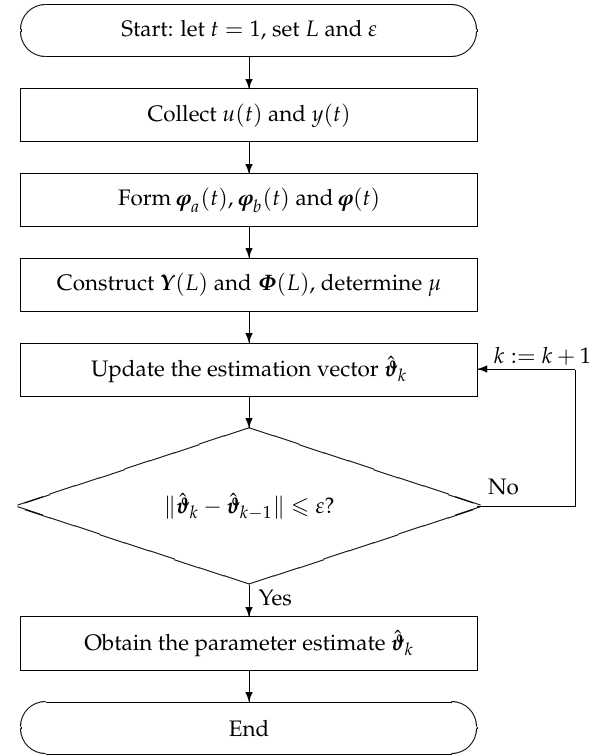
Figure 1. The flowchart of the gradient-based iterative (GI)